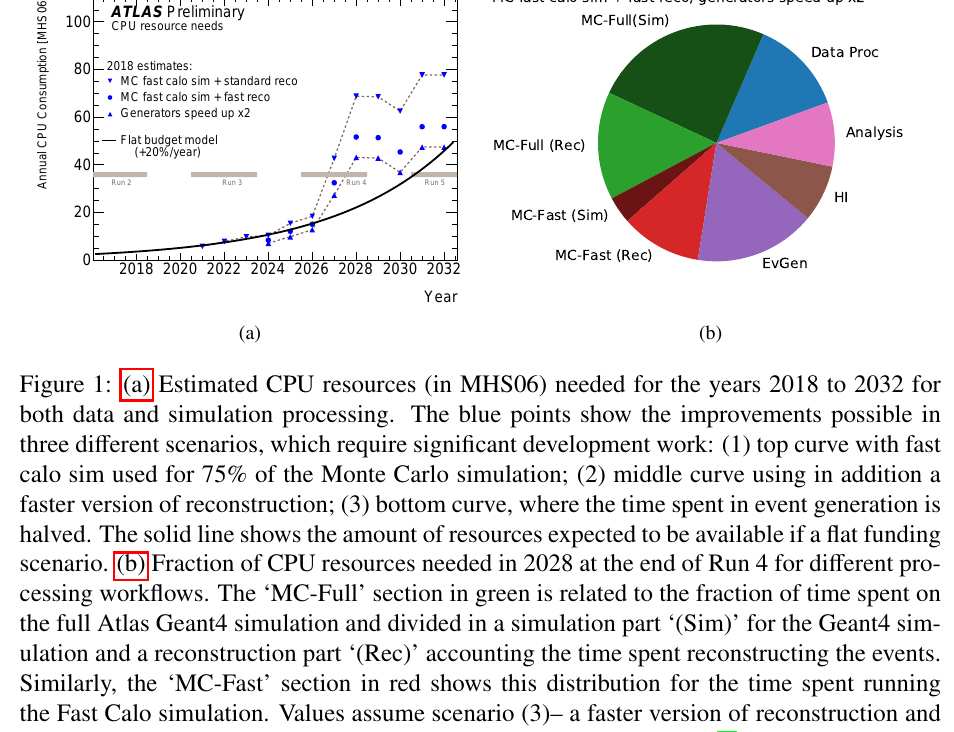
event generation speed-up by a factor of two. Figures taken from ref.